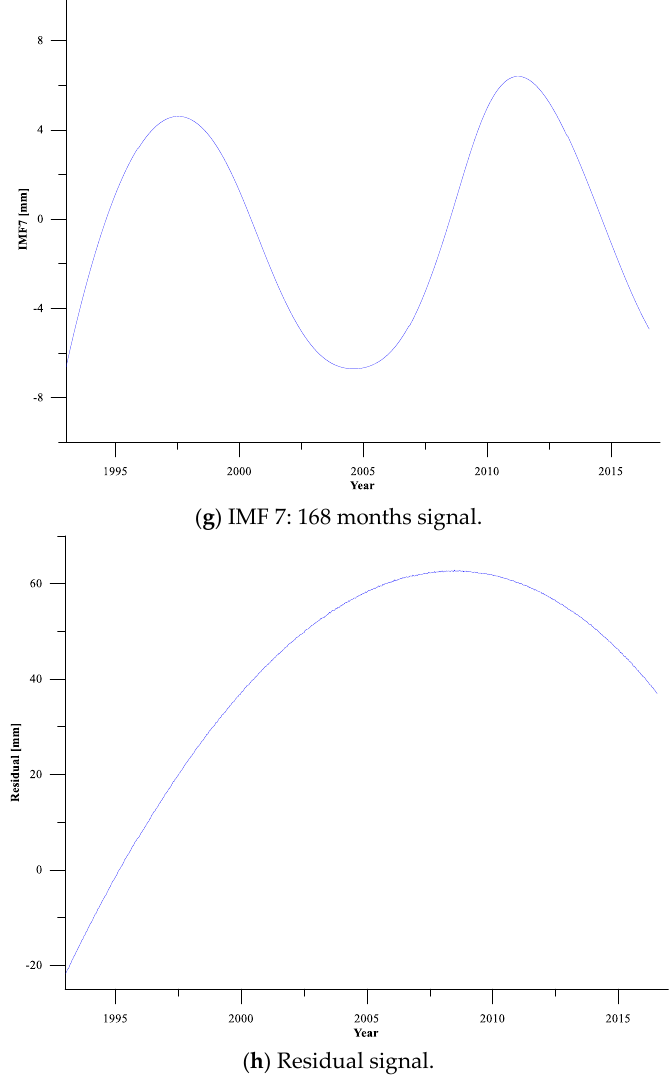
Figure 3. Complete Ensemble Empirical Mode Decomposition (CEEMD) decomposition results of SLA time series around Shandong Peninsula (Panels ( a – g ) represent the IMFs with cycles respectively, Panel ( h ) represents the residual.).